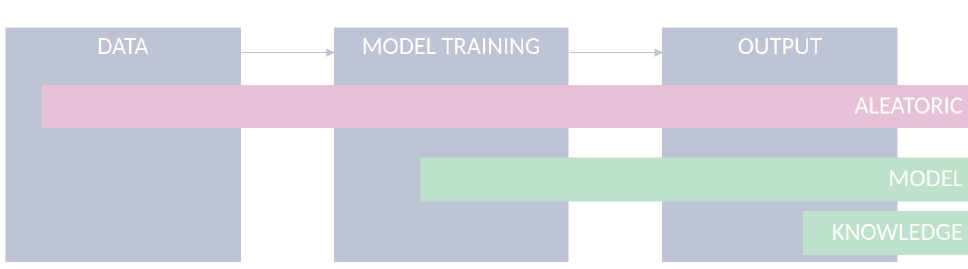
Figure 1. Uncertainty in Machine Learning (ML) classification